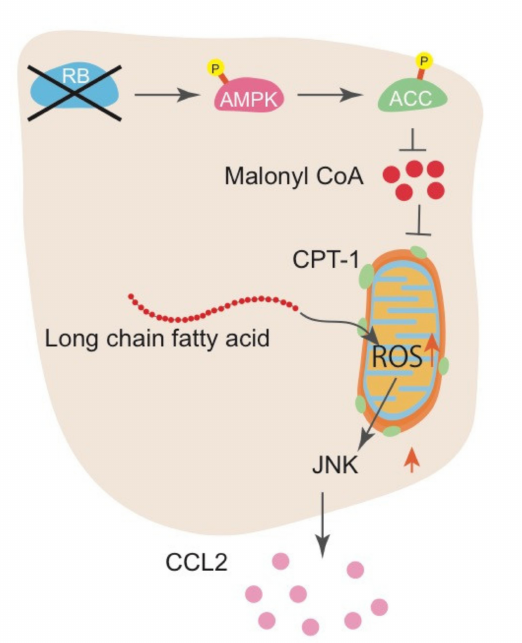
Figure 3. The mechanism of CCL2 upregulation following RB inactivation. RB inactivation increases AMPK phosphorylation and subsequent ACC phosphorylation, resulting in downregulation of malonyl-CoA synthesis. A decrease in malonyl-CoA allows CPT1 to transport long-chain fatty acids into mitochondria for FAO, promoting mitochondrial ROS